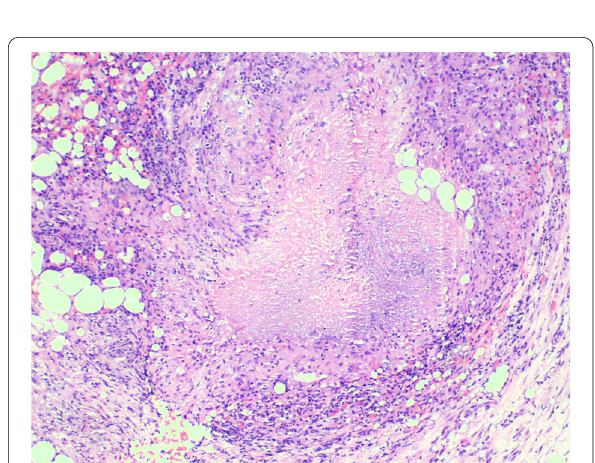
Fig. 3 Epithelioid histiocyte aggregate that constitute a granuloma with central caseating necrosis. H & E, 10